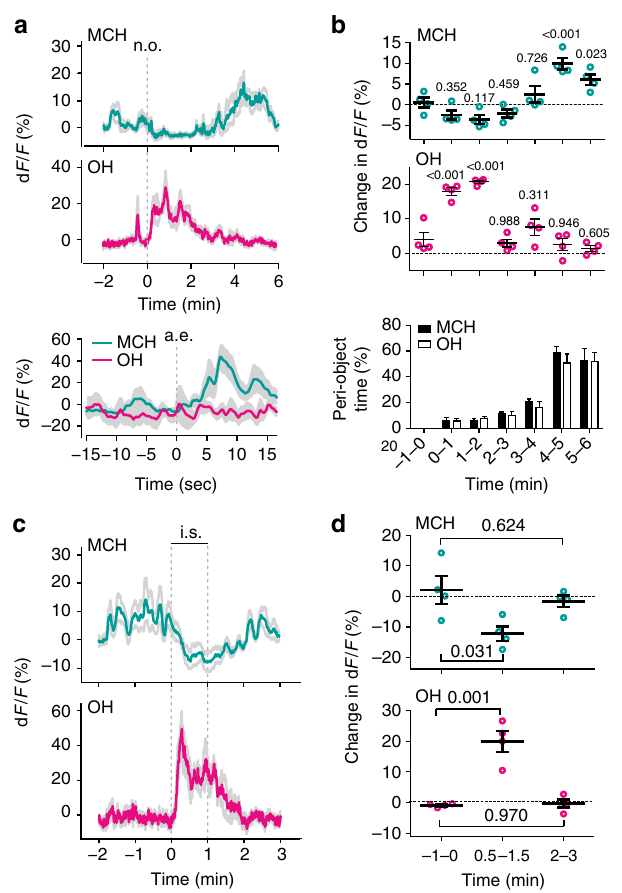
Figure 2 | Differential modulation of MCH and OH cells by sensory experiences. ( a ) Calcium signals from mice expressing GCaMP6s in MCH or OH cells aligned to novel object (n.o.) presentation (top and middle plots) or to the time of object area entry (a.e.; bottom plot). Turquoise or magenta lines are means, grey lines are s.e.m., n ¼ 4 mice per group. ( b ) Binned quantification of data in a (top plots) and object area entry (bottom plot). Changes in fluorescence (means ± s.e.m., black) and individual values, relative to values at (cid:2) 2min, before and after n.o. appearance (at indicated times). Numbers above data are P values of Dunnett’s multiple comparisons tests following one-way repeated measures analyses of variance (ANOVAs; MCH network: F(6,18) ¼ 16.67, P o 0.0001; OH network: F(6,18) ¼ 31.79, P o 0.0001). n ¼ 4 mice per group. ( c ) Calcium signals from mice expressing GCaMP6s in MCH or OH cells aligned to immobilization stress (i.s.) applied for 1min. Turquoise or magenta lines are means, grey lines are s.e.m., n ¼ 4 mice per group. ( d ) Quantification of data in c . Changes in fluorescence (means ± s.e.m., relative to values at (cid:2) 2min, before, during and after i.s. (at indicated times). Numbers above data are P values of Dunnett’s multiple comparisons tests following one-way repeated measures ANOVAs (MCH network: F(2,6) ¼ 5.7, P ¼ 0.041; OH network: F(2, 6) ¼ 27.77, P ¼ 0.0009). n ¼ 4 mice per group. brain (Fig. 5), or alternatively, also to the volumes of brain areas (Supplementary Fig. 5). The resulting global input maps revealed brain-wide distributions, and broad areal symmetries, of inputs to MCH and OH neurons (Fig. 5 and Supplementary Fig. 5). The greatest numbers of input neurons for MCH cells were found